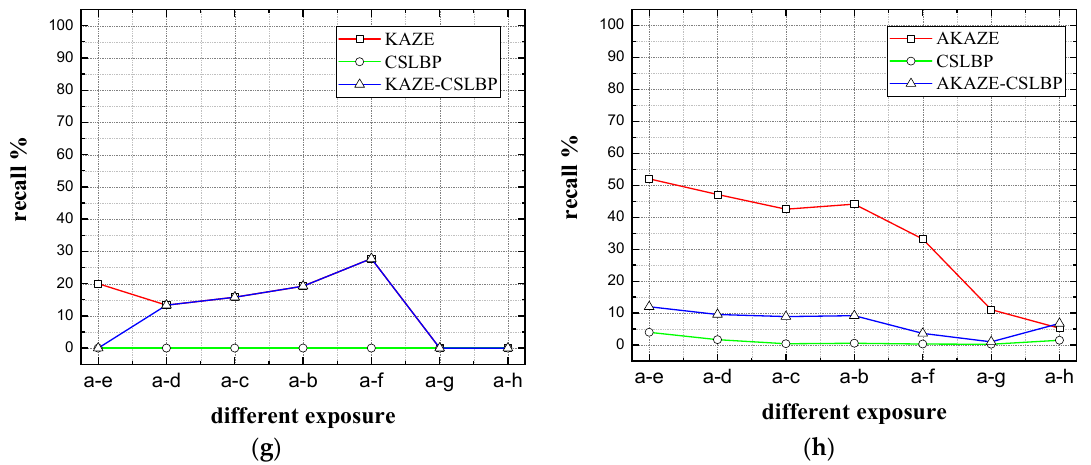
Figure 13. Matching results of the recall of Boat sequence for the eight original, the CSLBP, and the combined descriptors. The X label represents the matched images of Boat sequence, and the Y label denotes the recall for each descriptor. ( a ) SIFT features; ( b ) SURF features; ( c ) DAISY features; ( d ) BRISK features; ( e ) ORB features; ( f ) FREAK features; ( g ) KAZE features; ( h ) AKAZE features.